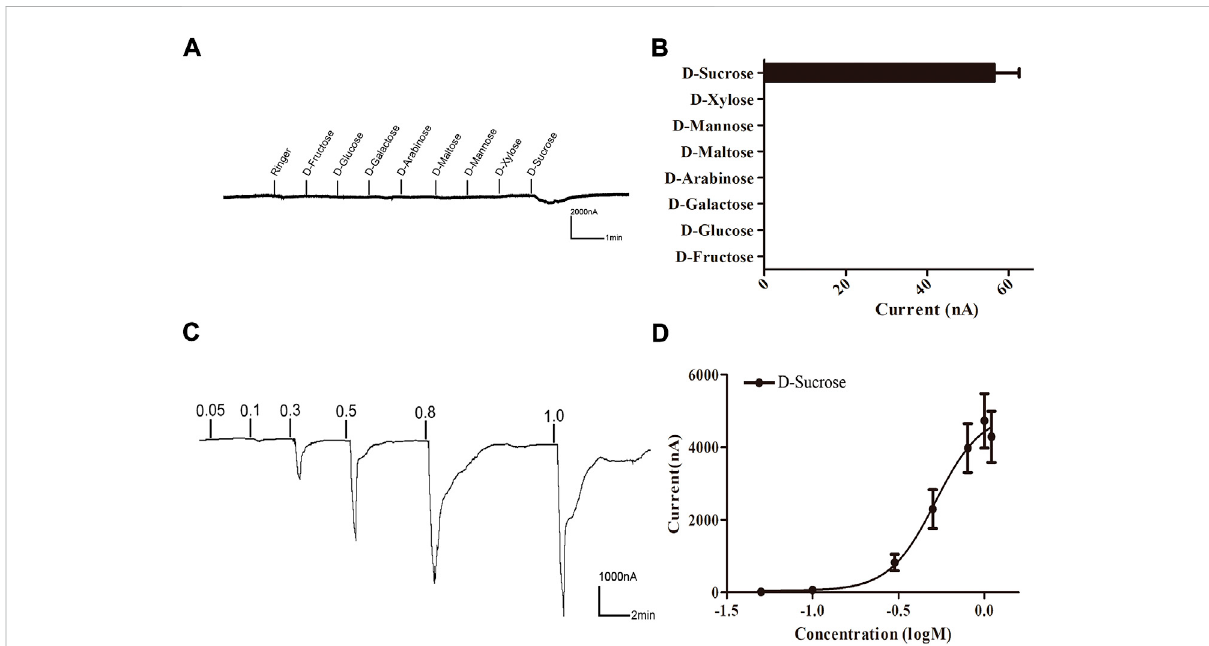
FIGURE 4 Responses of Xenopus oocytes expressing BtGR11 to different sugar ligands. (A) Inward current responses of Xenopus oocytes injected with BtGR11cRNAtosugarcompounds(0.1 M). (B) Responsepro fi leof Xenopus oocytesexpressingBtGR11.ErrorbarsindicateSEM(n=4). (C) Response ofBtGR11-expressing Xenopus oocytesto D-sucrose atdifferentconcentrations. (D) Dose – response curve ofBtGR11-expressing Xenopus oocytes to D-sucrose, with EC 50 = 0.563 M. Error bars indicate SEM (n =